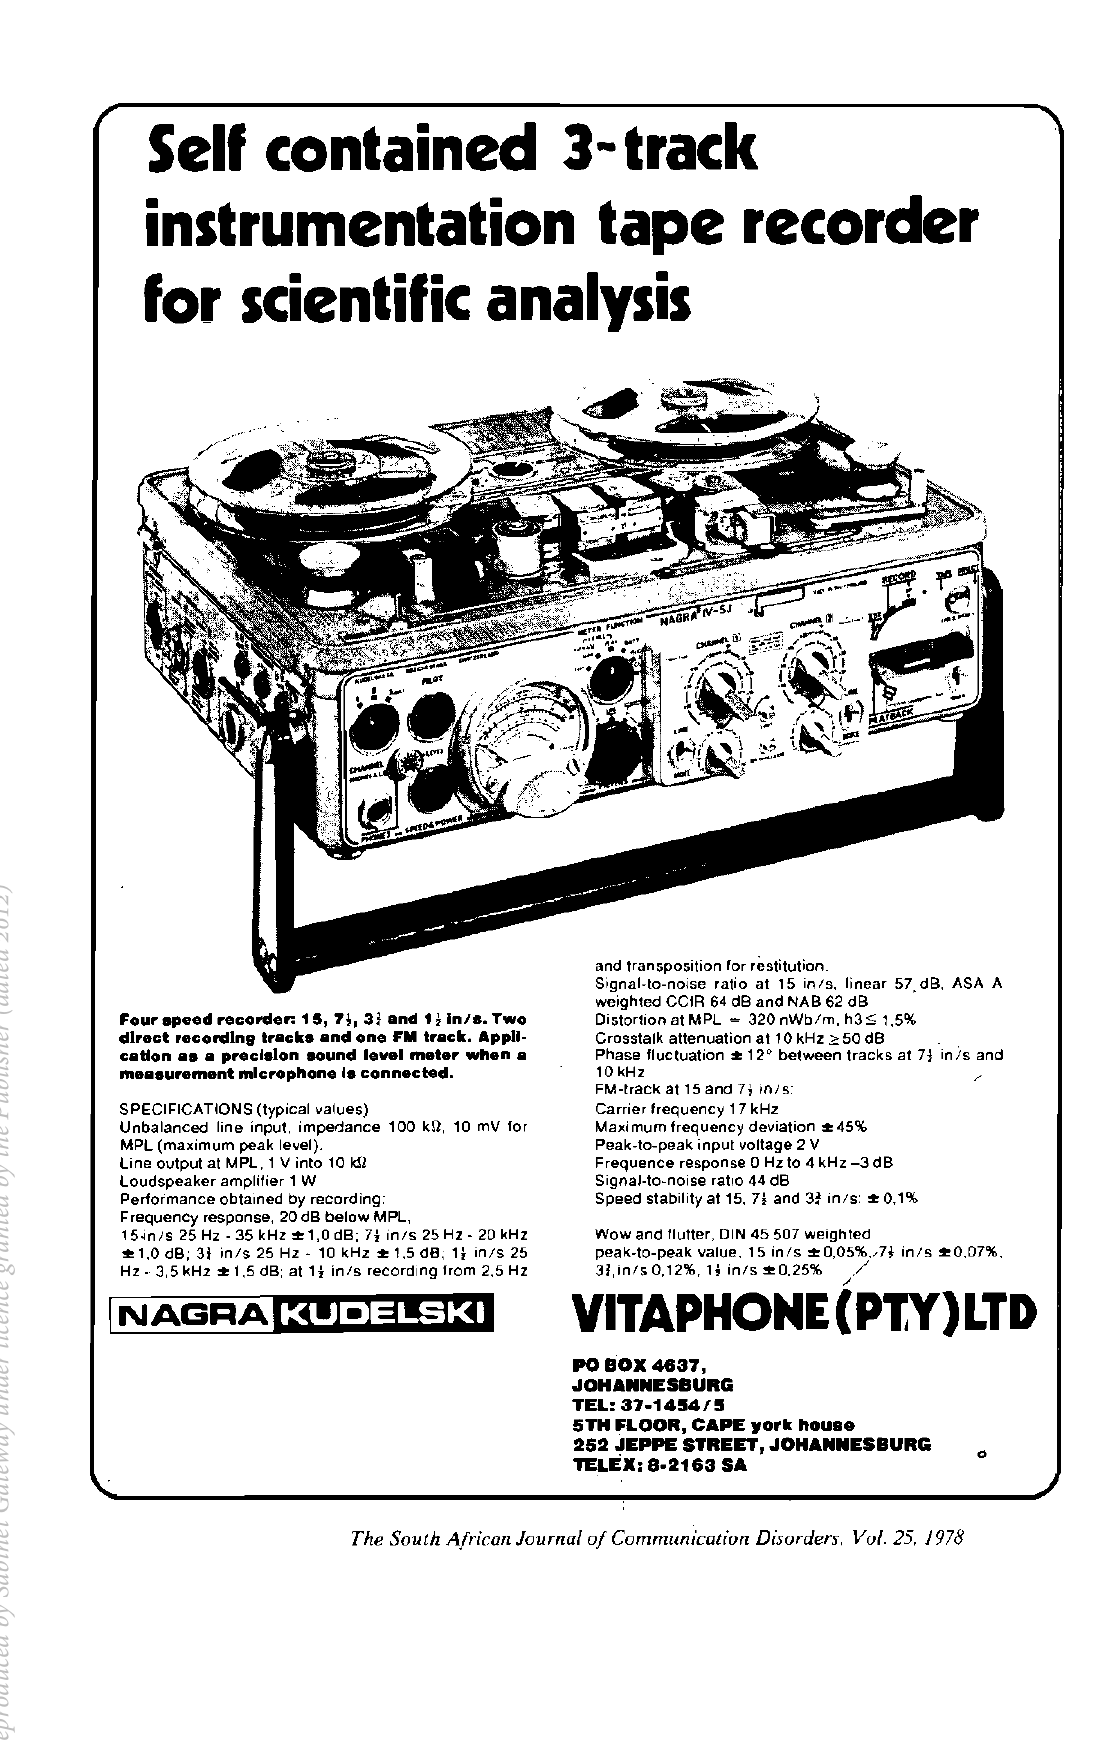
Speed stability at 15, 7i and 33 in/s: